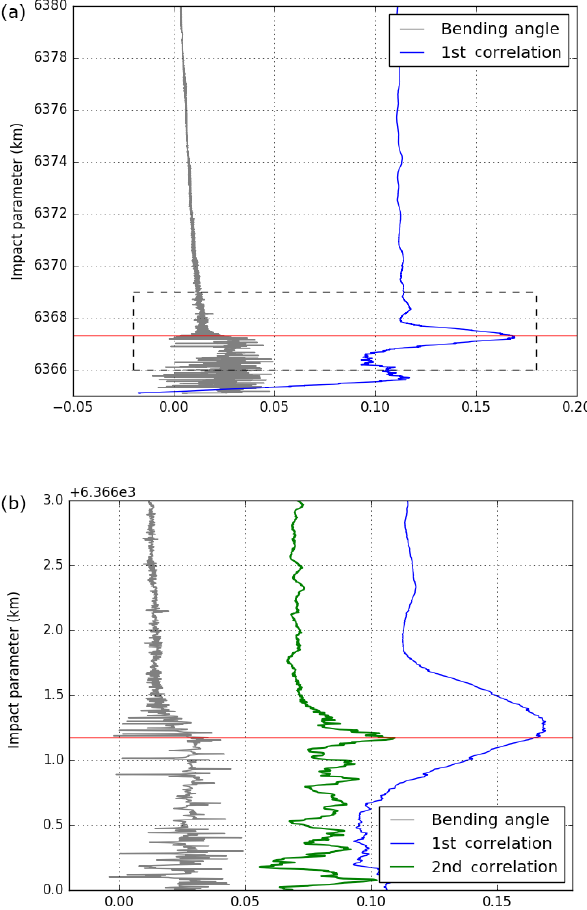
Figure A1. Ducting layer height determination using bending an- gle profiles. The correlation result with the long step function is shown in (a) with a blue line, which has been scaled and shifted for demonstration. The peak location identifies the approximated duct- ing layer height. The correlation result with the short step function is shown in (b) with a green line. Panel (b) is the enlarged image of the dashed-line rectangle shown in panel (a) . The corresponding im- pact parameter of the sharp bending angle transition can be found at the location of the second correlation peak within the range of the first correlation hump ( ± 250m). The correlation results in both panels are scaled down and shifted to fit into the